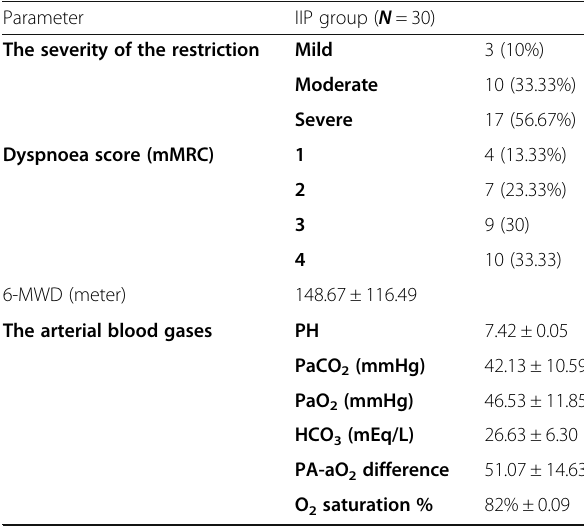
Table 1. The study involved 30 patients and 20 healthy individuals as a control group.